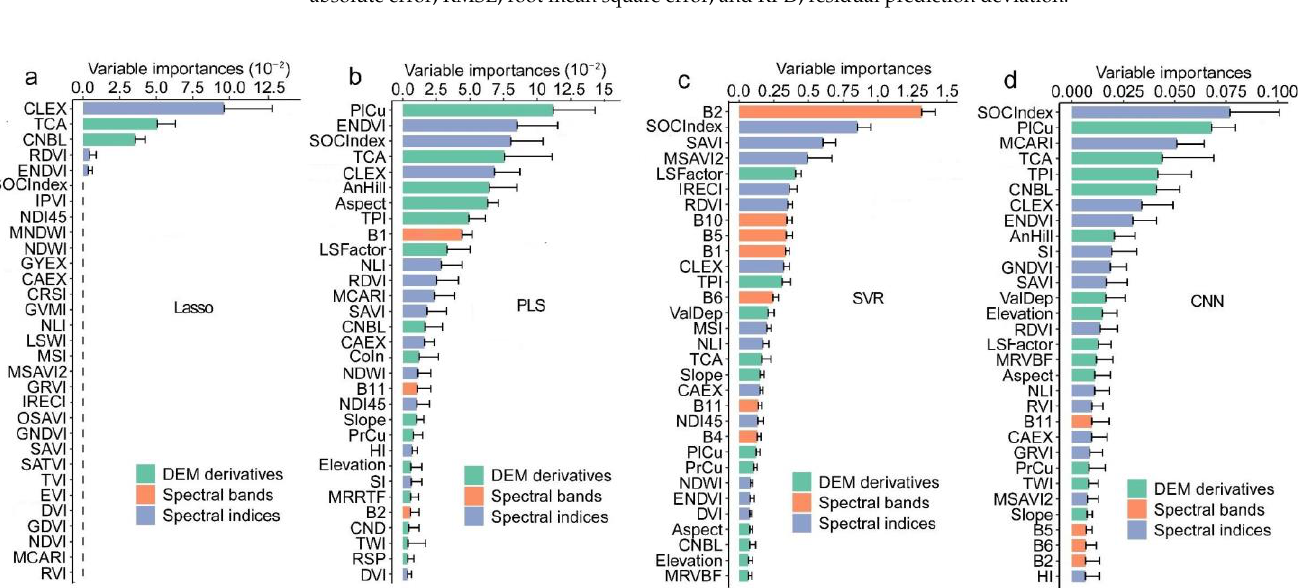
Figure 6. Variable importance of Sentinel-2 bands, indices, and DEM derivatives for SOM prediction in Lasso ( a ), partial least square (PLS, ( b )), support vector regression (SVR, ( c )), and convolutional neural network (CNN, ( d )). The interpretation of the abbreviations can be found in Tables 1, 2, and S1.